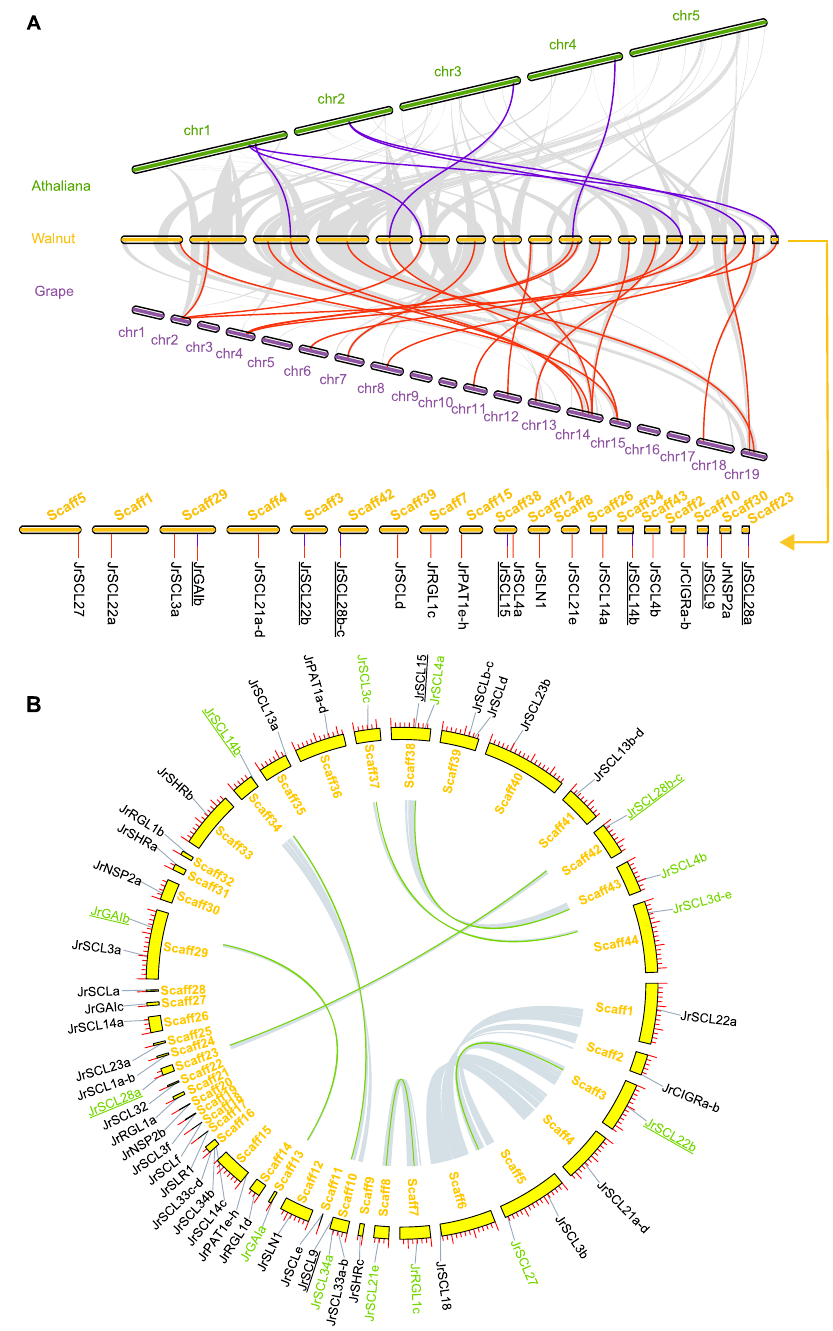
Figure 4. ( A ) Synteny analysis of GRAS genes between Arabidopsis, walnut and grape. The gray lines in the background indicate the collinear blocks within walnut and other plant genomes, while the blue and red lines highlight the syntenic GRAS gene pairs. ( B) Synteny analysis of JrGRAS genes. Gray lines indicate all synteny blocks in the walnut genome, whereas the green lines suggest duplicated GRAS gene pairs. The gene name with an underline means this gene was identified as the synteny gene between different